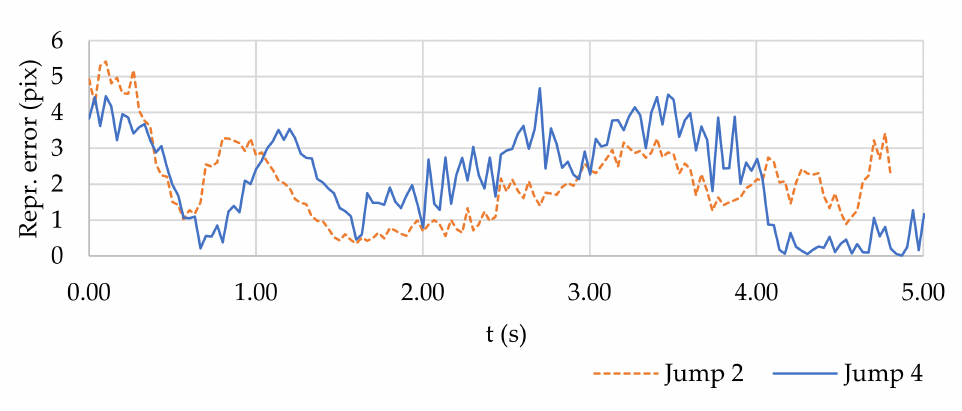
Figure 8. Reprojection error for the spherical target during Jumps 2 and 4. Fine noise component caused by vibrations from wind.